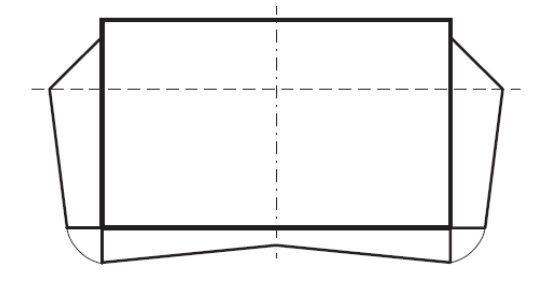
Figure 4: Distribution of hydrodynamic pressure at the center of the ship